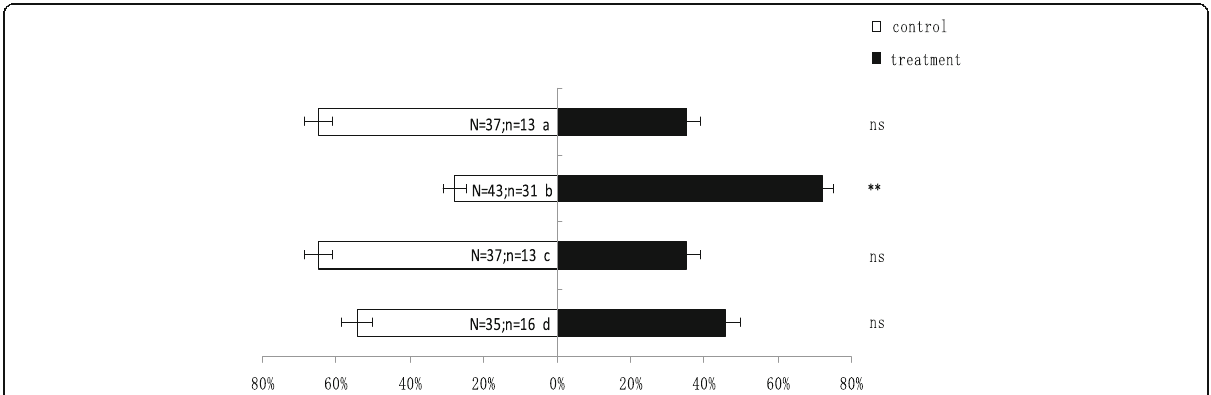
Fig. 2 Behavioural responses of Aromia bungii individuals to living Aromia bungii adults of the same or opposite sex. a Responses of A. bungii males to the odour of four males. b Responses of A. bungii males to the odour of four females. c Responses of A. bungii females to the odour of four females. d Responses of A. bungii females to the odour of four males. N, number of responsive A. bungii ; n, number of A. bungii choosing the treatment group; significant difference at the 0.01 level (nonparametric test, bivariate correlation, Wilcoxon test)